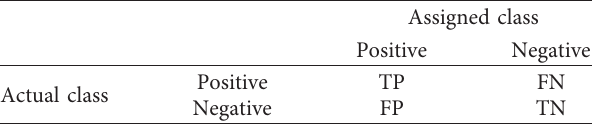
Table 1: The confusion matrix with two clusters.